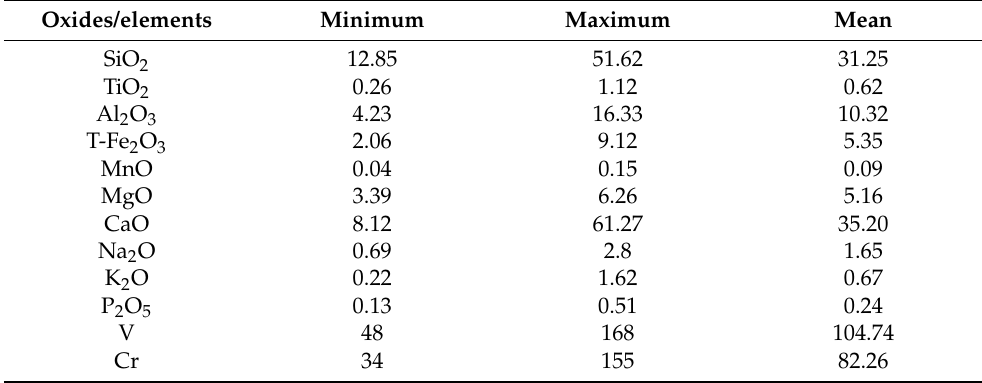
Table 2. Summary statistics showing the concentration ranges and average of oxides (%) and minor and trace elements ( µ g/g), elemental ratios, and enrichment factor (EF) of the environmentally significant trace elements in the bottom sediments of Sharm